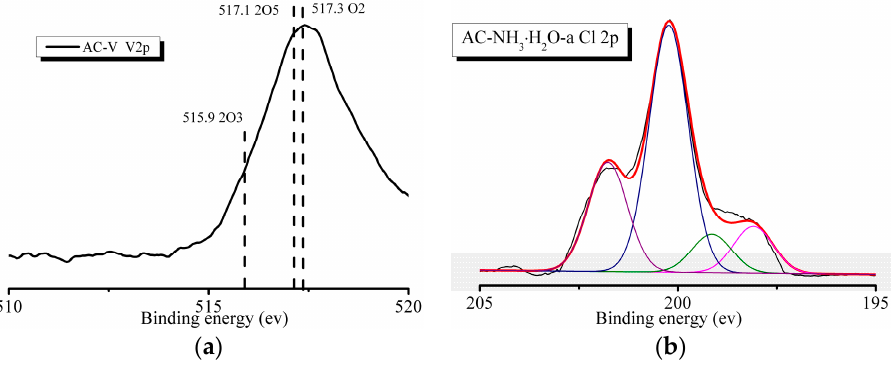
Figure 6. XPS results of the samples. ( a ) O 1s spectrum of AC–O. ( b ) Area percentages of the functional groups on the basis of the O 1s spectra.